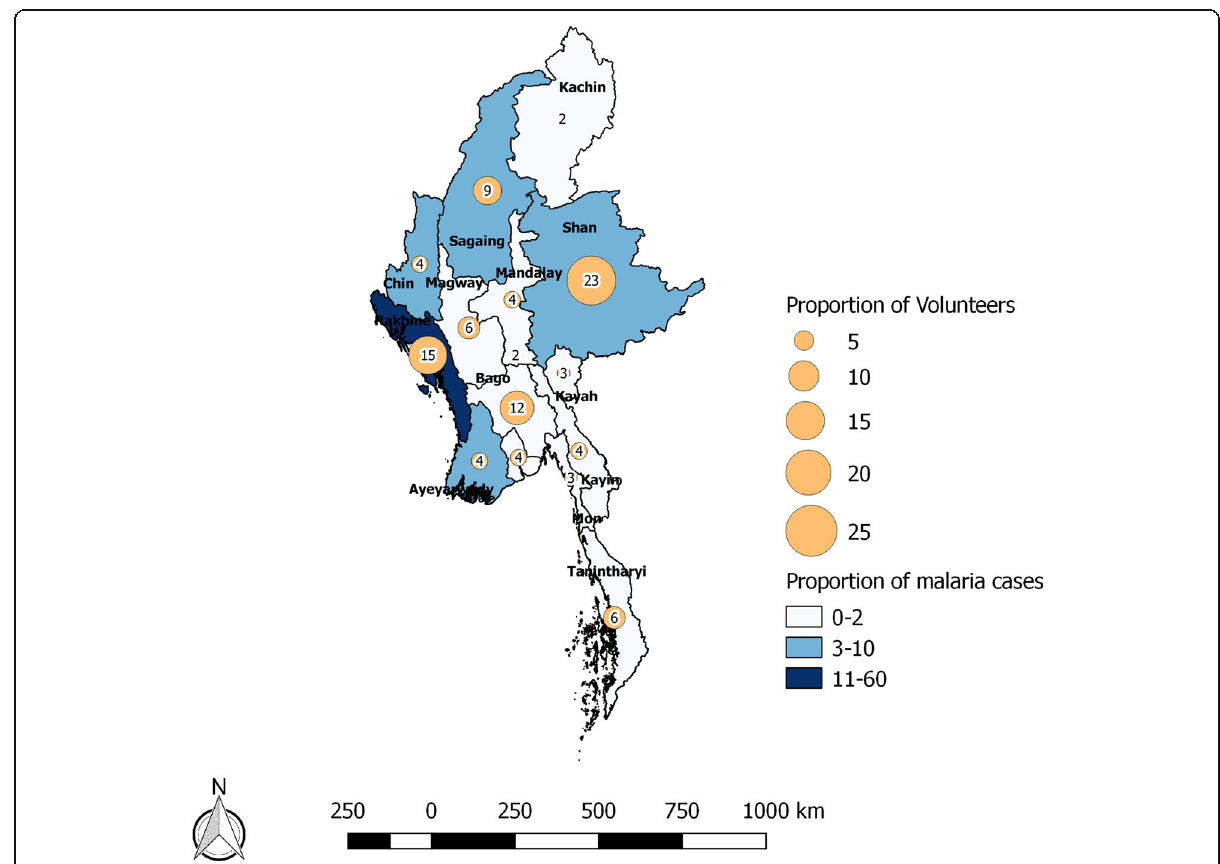
Fig. 5 Map of Myanmar showing the distribution of village health volunteers and malaria cases identified by them in different states and regions,